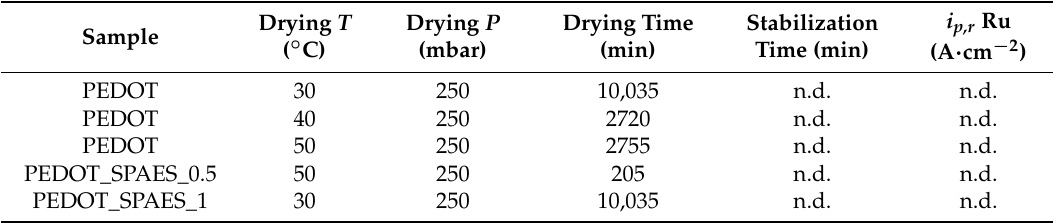
Table A3. Drying temperature, pressure and time of PEDOTs’, PEDOT_Naphs’, and PEDOT_SPAESs’ polymeric solutions in DMSO, and the stabilization time and current of the corresponding modified electrode.